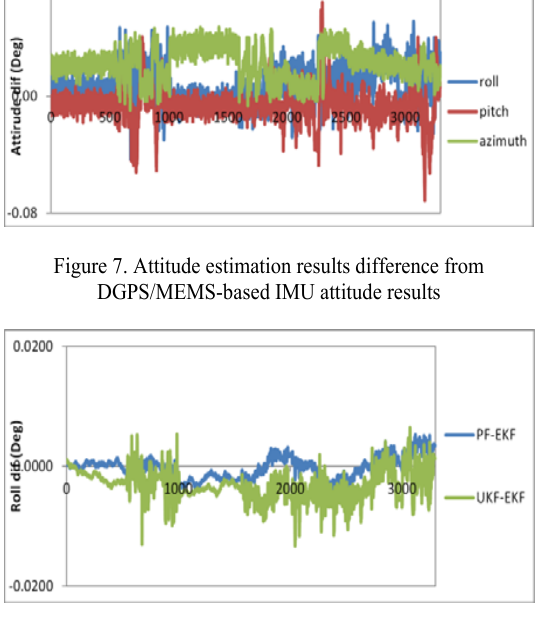
Figure 8. Roll estimation results for PF and UKF difference EKF